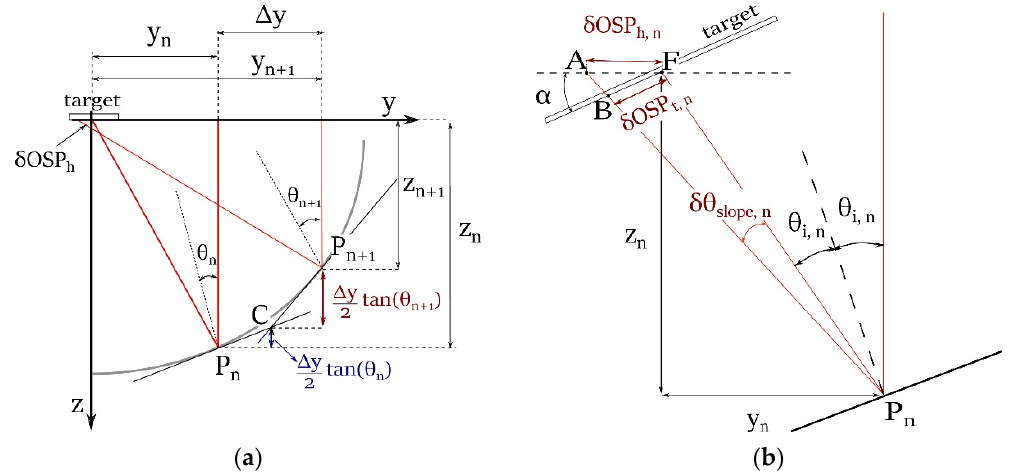
Figure 8. Diagram for the geometrical calculation for the ( a ) horizontal configuration and ( b ) tilted configuration.